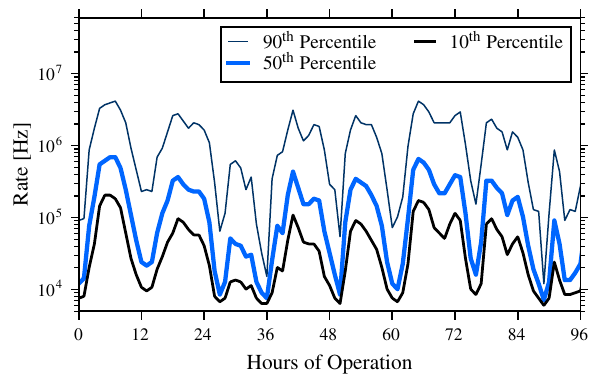
Fig. 12 Hourly percentiles of the background rates over four days. A clear time structure corresponding to the 12.5 h tidal cycle is visible. The percentiles are chosen instead of the mean rate, as the percentiles are unaffected by the DAQ saturation limit (see Fig. 11)